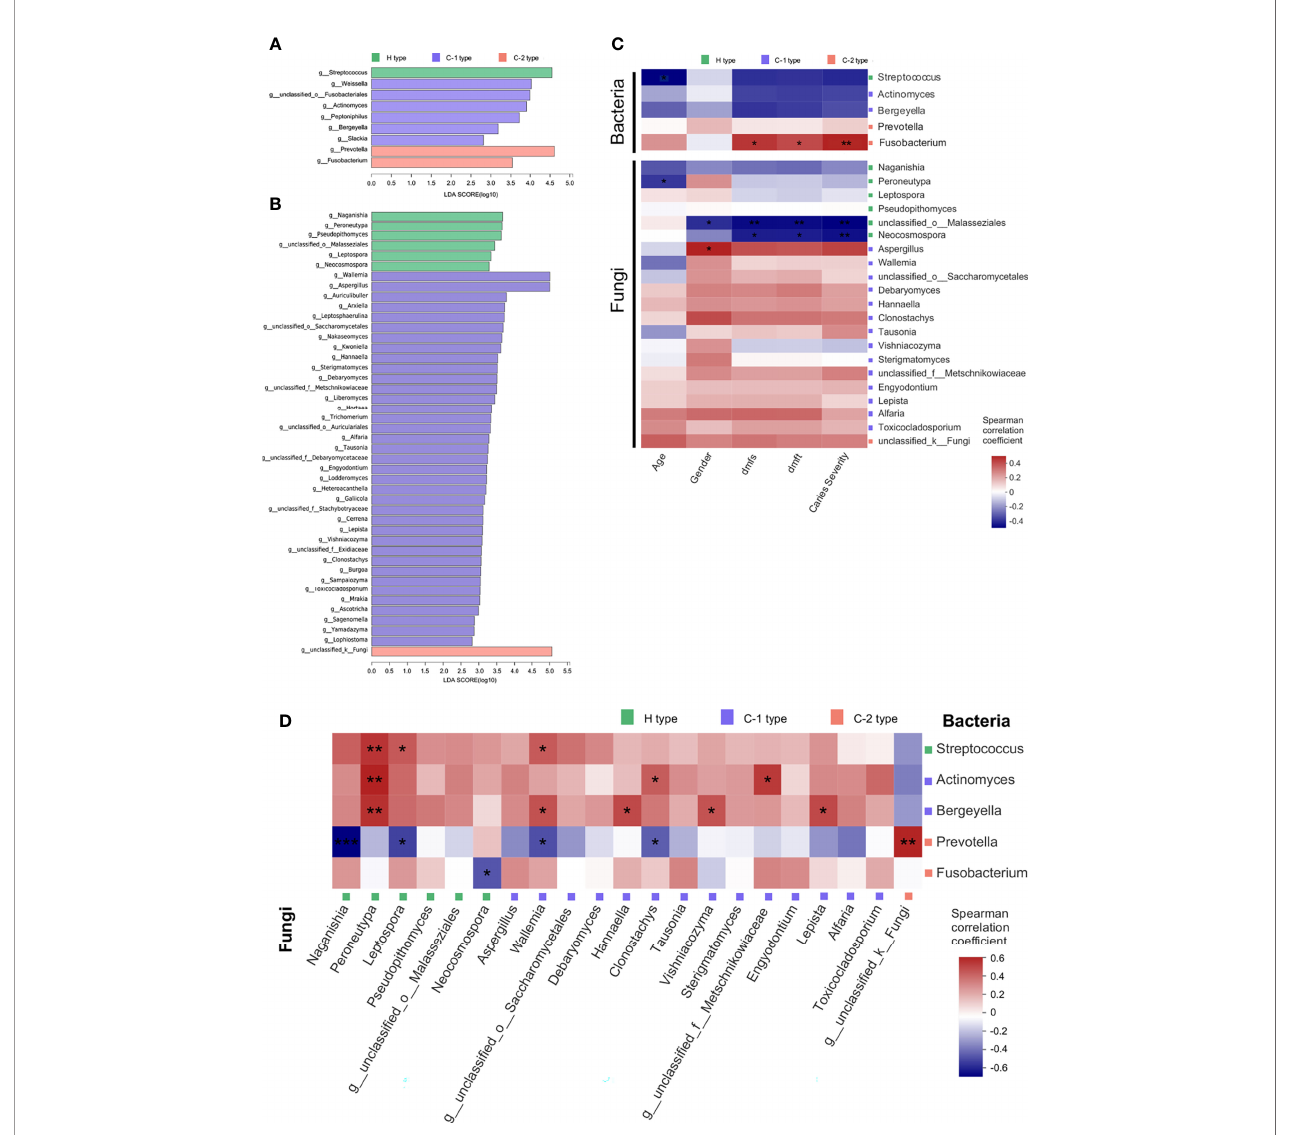
FIGURE 4 | Potential crosstalk between the oral microbiome and mycobiome in children with different oral health status. (A) LDA scores of distinct salivary bacteria among groups at the genus level. (B) LDA scores of distinct salivary fungi among groups at the genus level. (C) Spearman rank correlation between host properties and abundances of distinct salivary bacteria and fungi. (D) Spearman rank correlation between distinct salivary bacteria and fungi. * p < 0.05, ** < 0.01, *** p < 0.001. C-1 type, caries-related type 1; C-2 type, caries-related type 2; dmfs, decayed, missing, or fi lled surfaces; dmft, decayed, missing, or fi lled teeth; H type, health- related type; LDA, linear discriminant